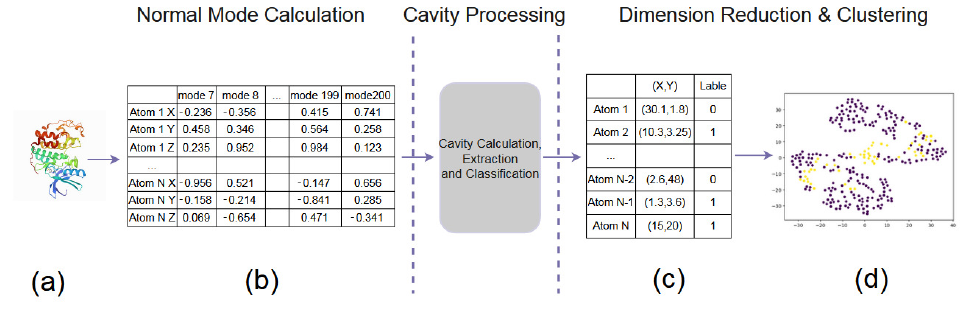
Figure 3. The pipeline of our data preparation. ( a ) A PDB file. ( b ) Normal Mode Calculation. ( c ) Cavity Processing. ( d ) Dimension Reduction &